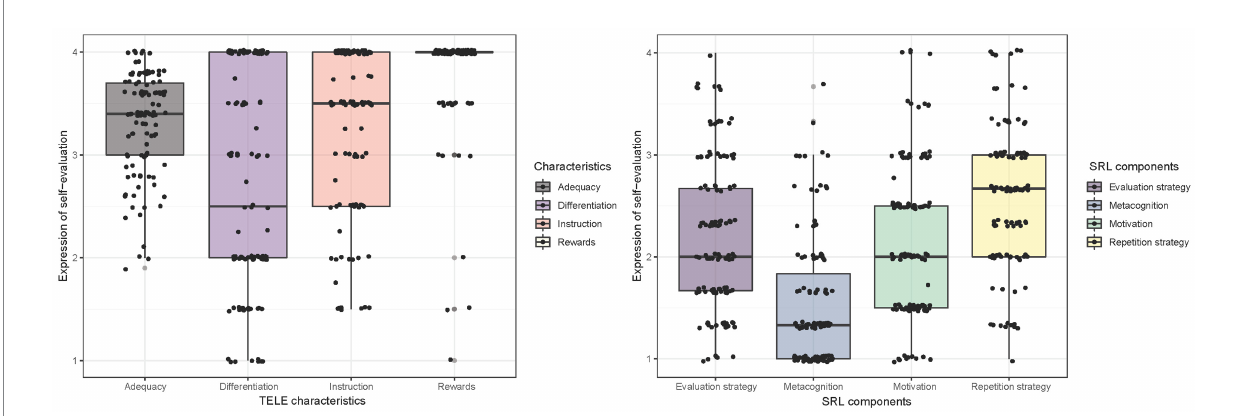
FIGURE 1 Boxplots of the rating of the quality characteristics of the technology-enhanced learning environment (TELE) and self-estimated self-regulated learning (SRL)